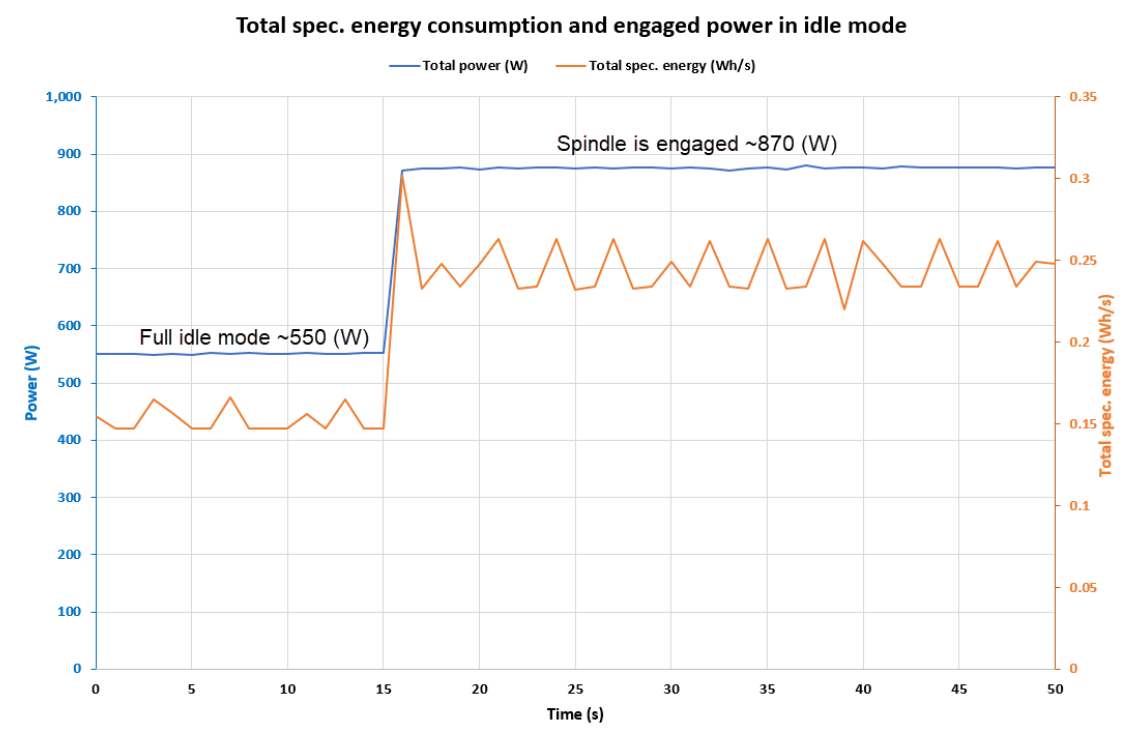
Figure 7. Total specific energy consumption and engaged power for the idle mode.